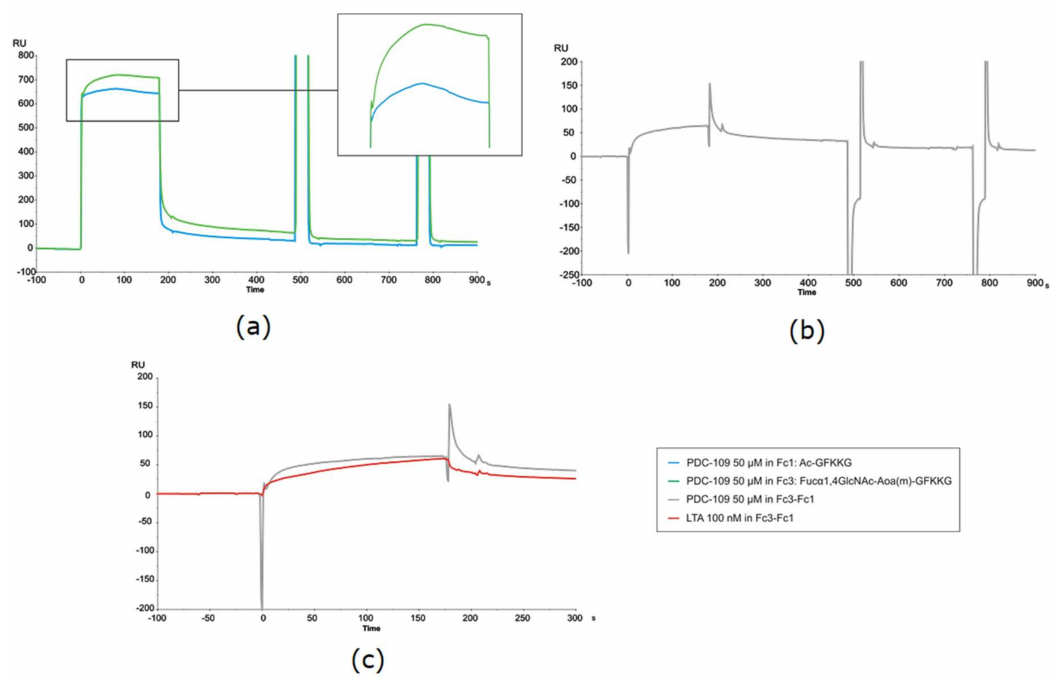
Figure 5. ( a ) SPR sensorgrams of the binding of PDC-109 at 50 µ M to reference surface, i.e., Ac-GFKKG (blue trace), or to Fuc- α 1,4-GlcNAc-Aoa(m)-GFKKG glycoprobe immobilized (green trace). Enlarged on the right, the unusual signal progression in association phase is highlighted; ( b ) Differential curve for PDC-109 kinetic studies obtained after subtracting the reference channel; ( c ) Comparison of differential curves from PDC-109 (grey trace) vs. lectin LTA (red